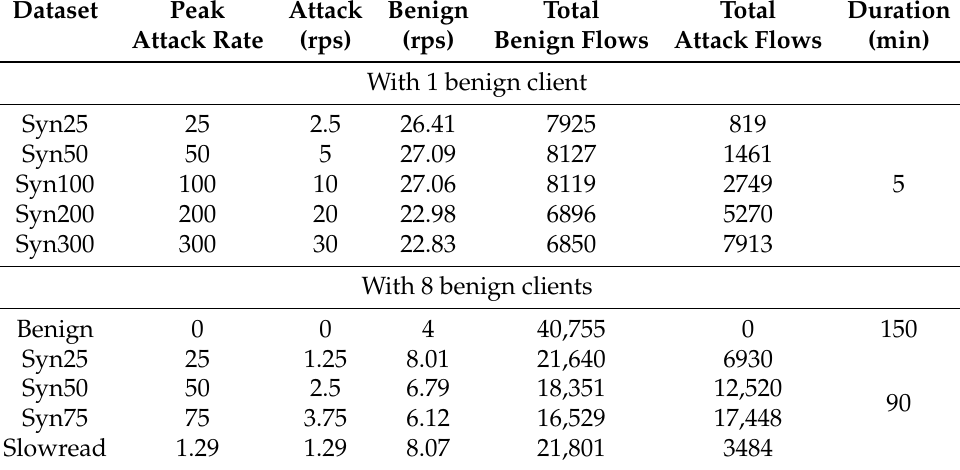
Table 1. The attack traffic in the UTSA-2021 dataset. Syn25 through Syn300 denote traffic with benign flows and TCP SYN floods. Slowread denotes the traffic with benign flows and Slow Read attack flows. Benign denotes traffic with only benign flows. All benign traffic is generated using the web client and server codes we created. There are two types of benign traffic scenarios. In the one-client scenario, a web client downloads a file from a web server back to back. In the eight-client scenario, eight web clients download files from two web servers back to back, but at a slower rate owing to